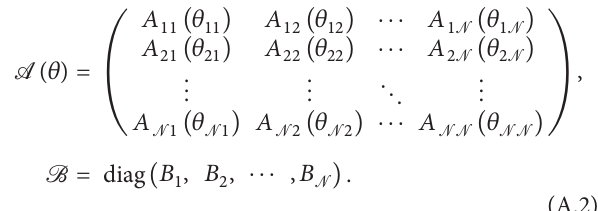
Figure 3: Time histories of 𝑥 3 (𝑡) and 𝑥 3 (𝑡) .